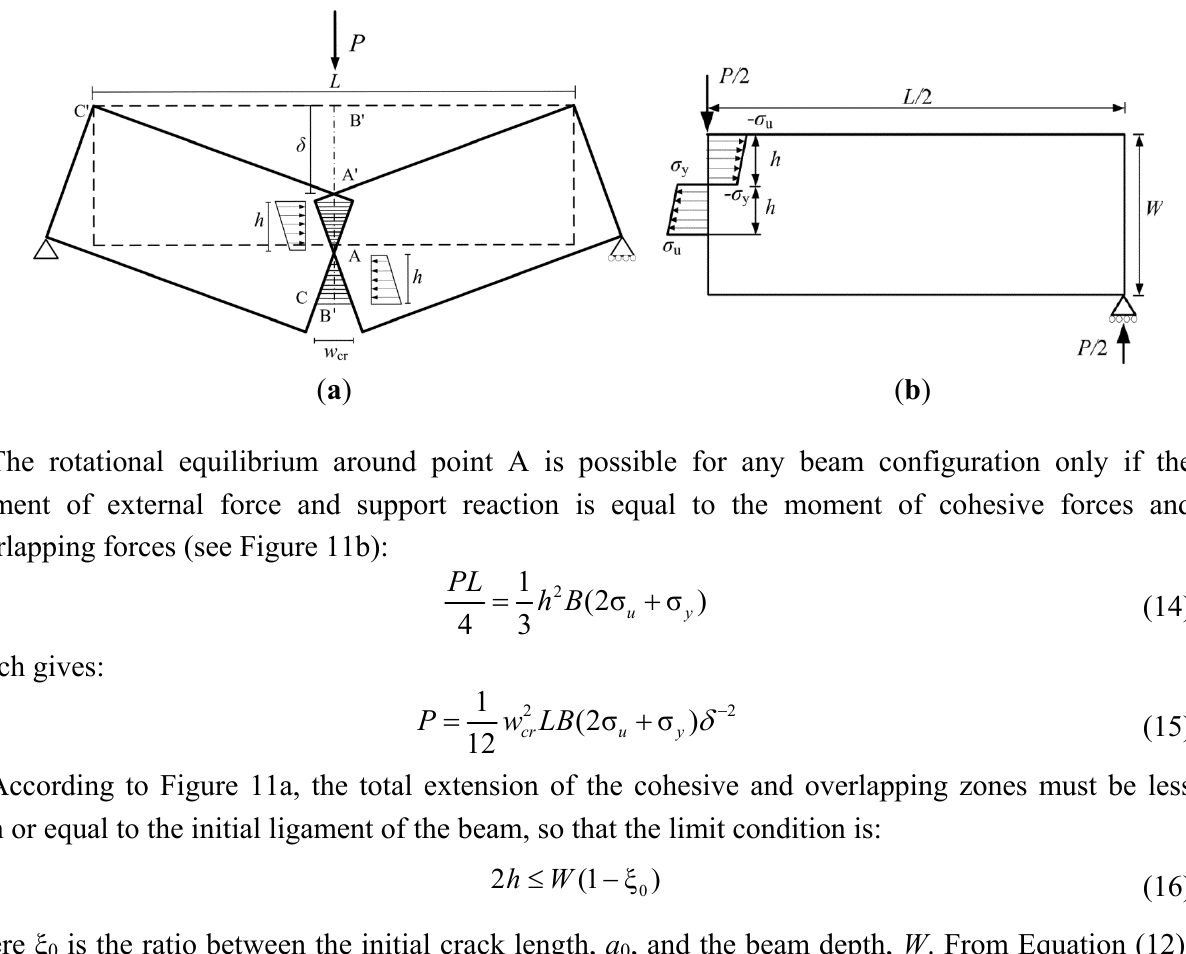
11. Limit analysis for TPB test: ( a ) limit condition of fracture with cohesive and overlapping forces; ( b ) cohesive and overlapping force distributions along the symmetry